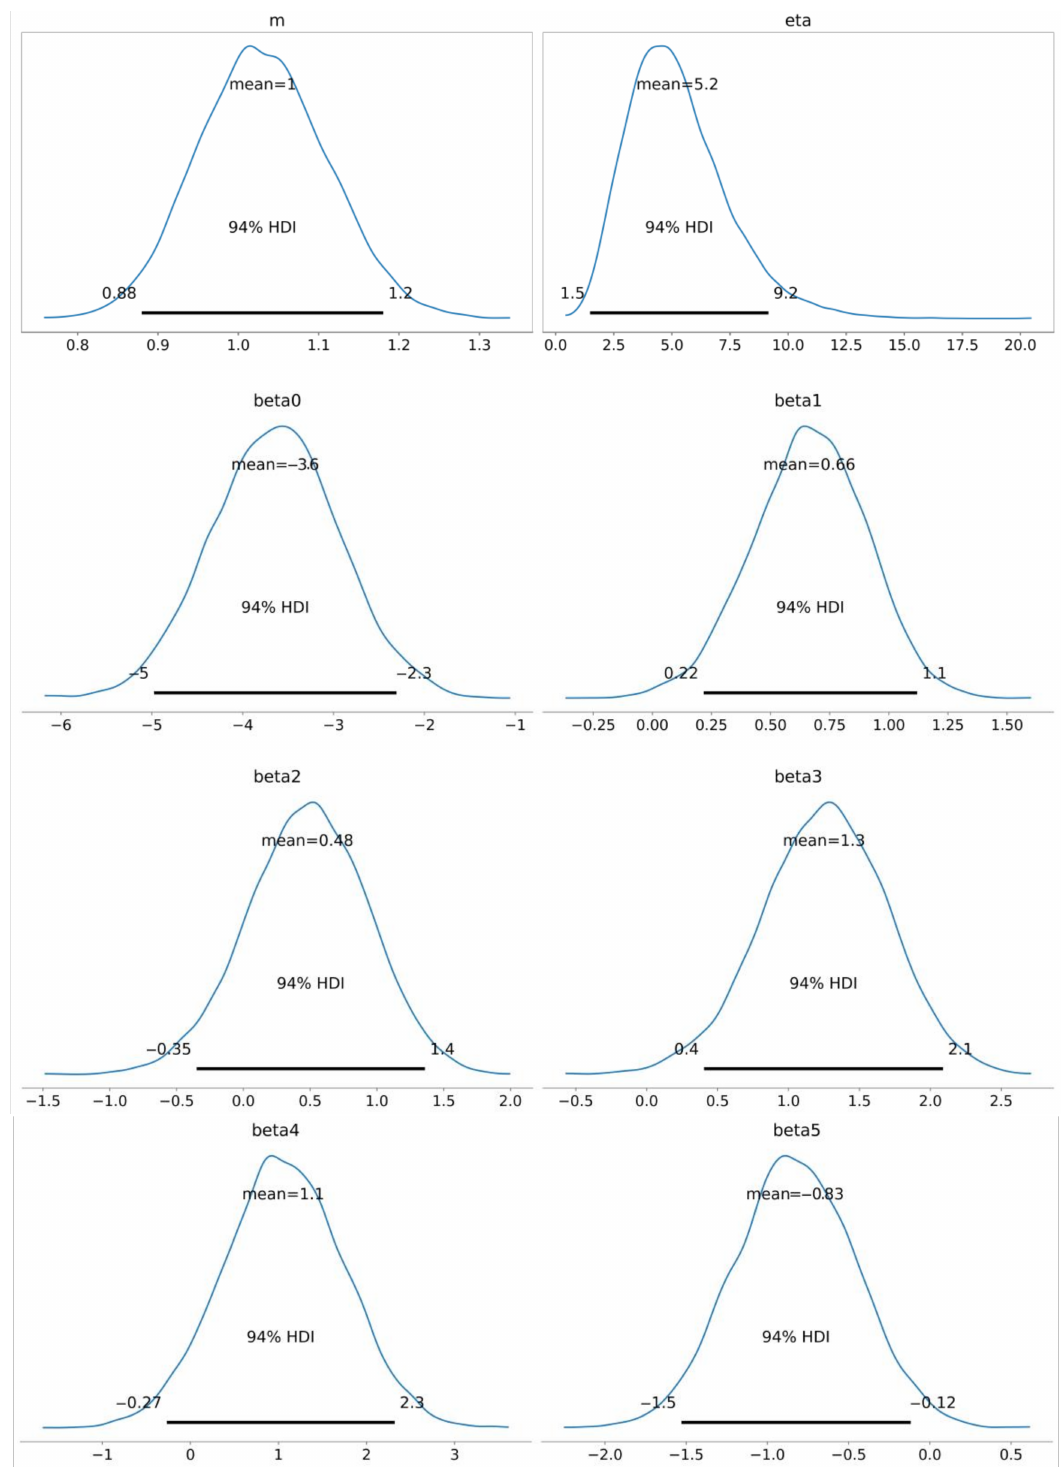
Figure 8. Posterior distributions of the model